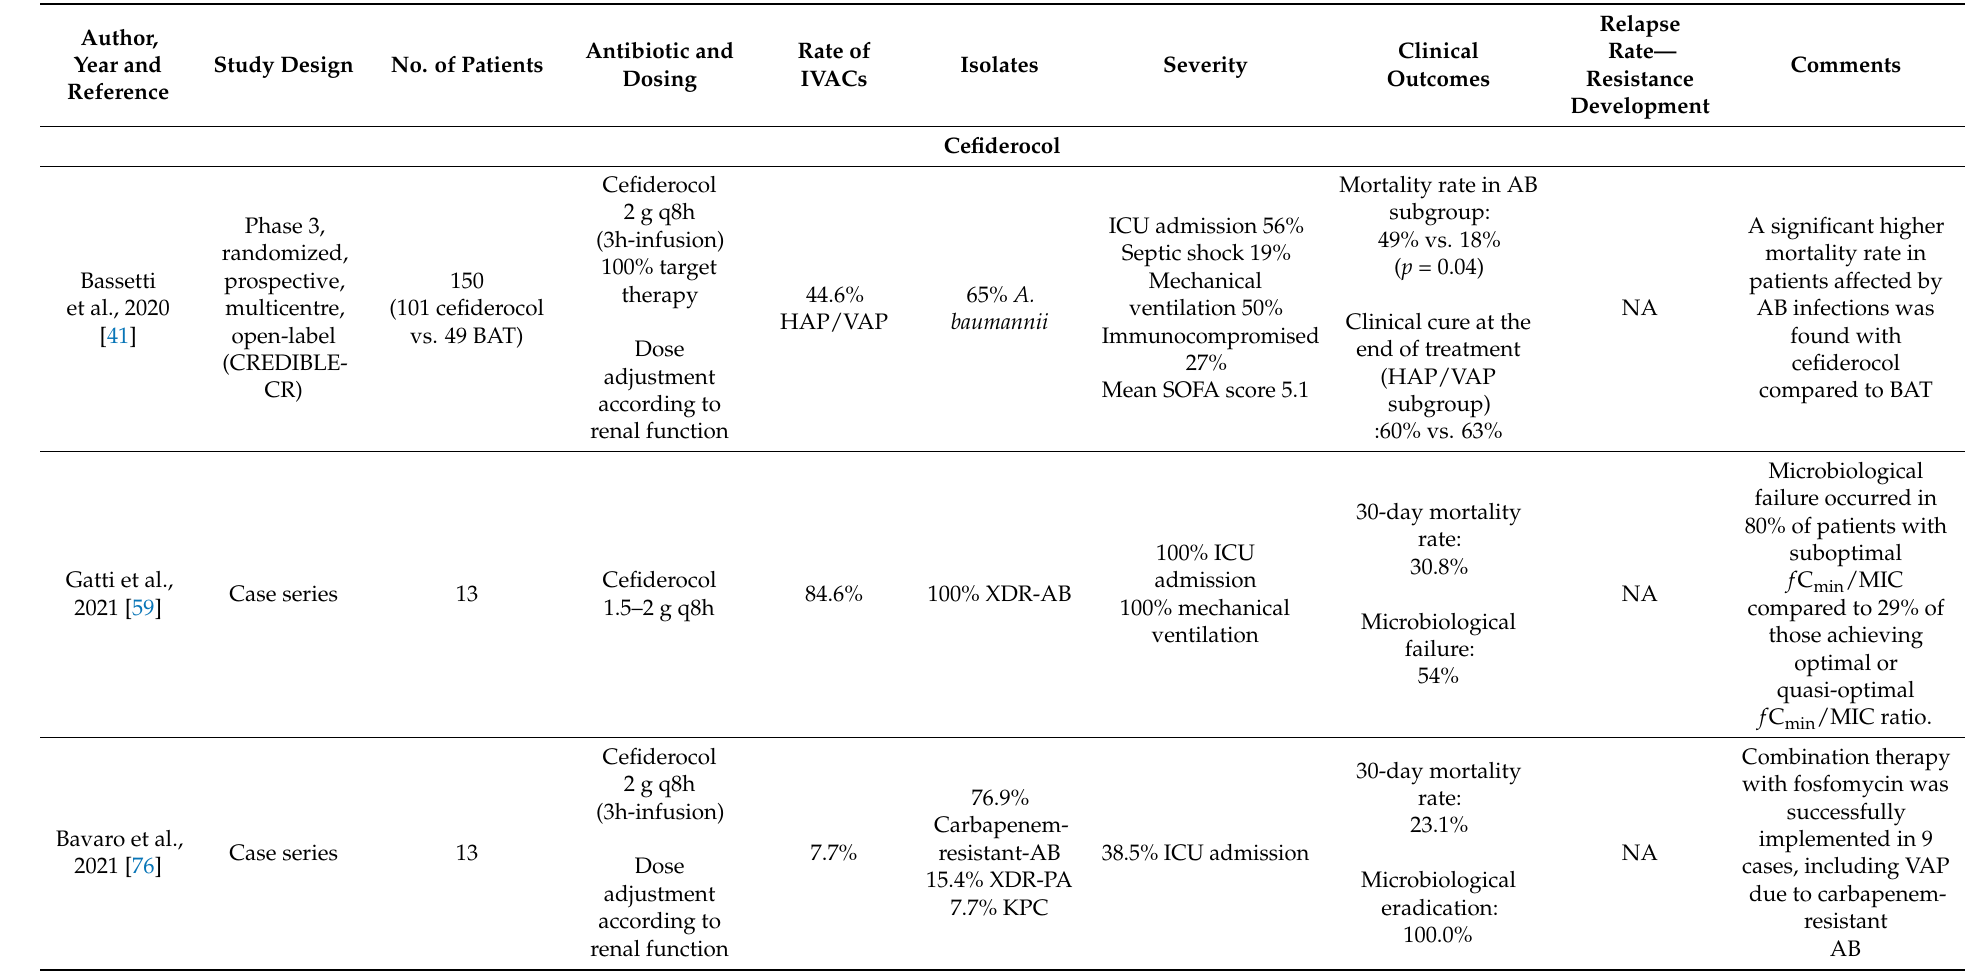
Table 6. Summary of the studies investigating the treatment of carbapenem-resistant Acinetobacter baumannii infection-related ventilator-associated complications (IVACs) with cefiderocol or combination therapy between fosfomycin and